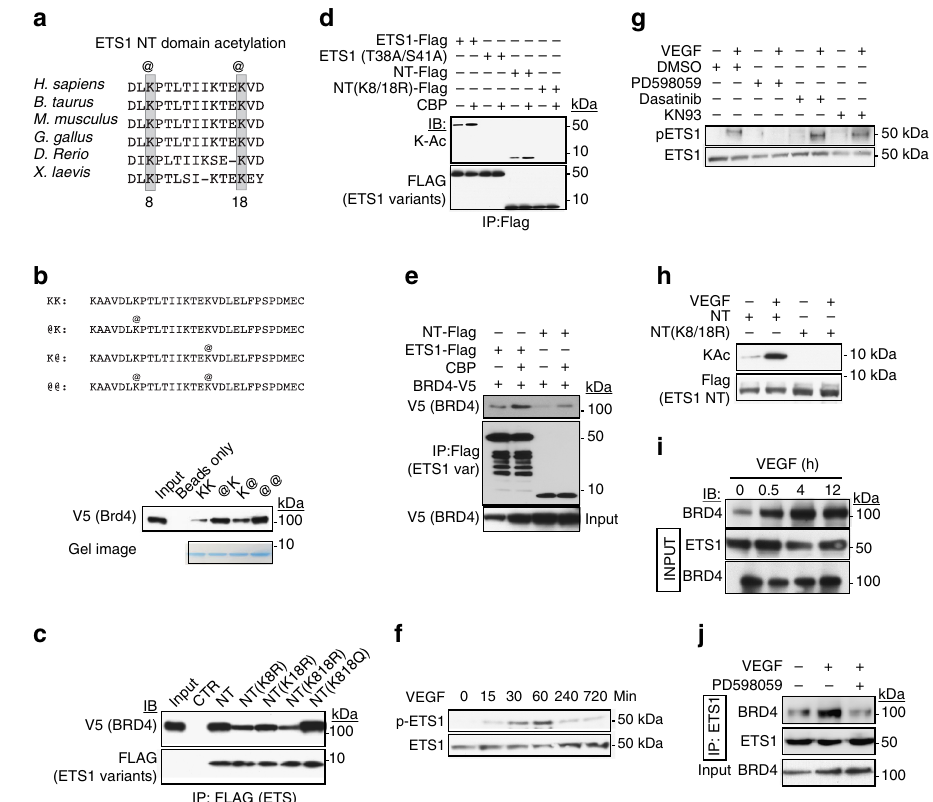
Fig. 4 VEGF increased ETS1 acetylation and interaction with BRD4. a ClustalW alignment of a region within the ETS1 NT domain. K8 and K18 were major sites of acetylation, as determined by mass spectrometry. b ETS1 NT acetylation enhances BRD4 binding. Peptides corresponding to the N-terminus of ETS1 were synthesized with either lysine or acetyl-lysine (@) at positions 8 and 18. Immobilized peptides were incubated with V5-BRD4-containing